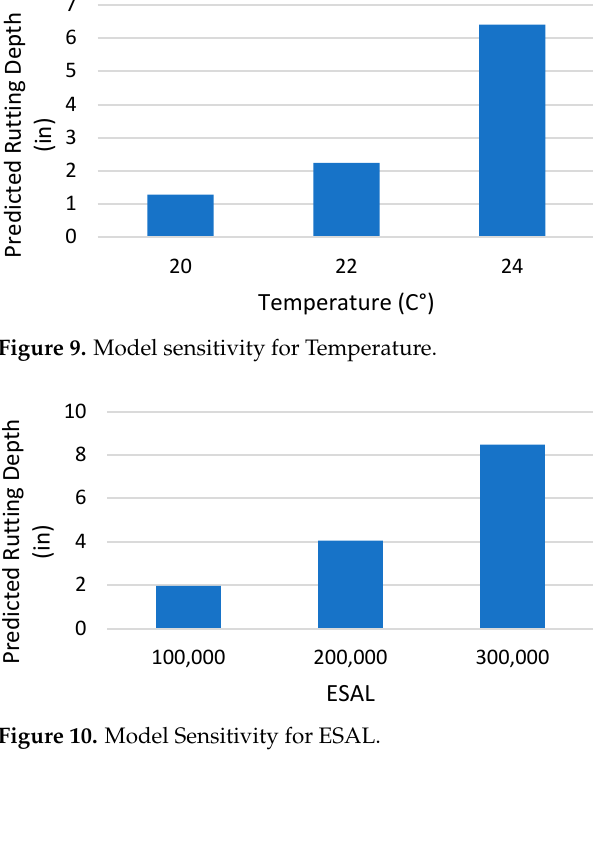
Figure 11. Model Sensitivity for Resilient Modulus. The results of the sensitivity analysis for ru tt ing depth showed that input variables such as temperature and ESAL are directly correlated with the dependent variable, the ru tt ing depth. Whereas, thickness and the resilient modulus were inversely correlated to the ru tt ing depth. 9. Summary and Conclusions A ru tt ing depth prediction model was developed using ANN. Seventy observations extracted from the LTPP database were used for the data collection, the model was fed with four inputs; temperature, ESAL, resilient modulus, and thickness. an R 2 with a value of 0.87 was developed. Comparing this R 2 with the 0.64 that was observed from the linear regression, the ANN shows a be tt er result and higher R 2 . An Equation was extracted using weights and biases and veri fi ed for ru tt ing depth. The extracted equation and ANN